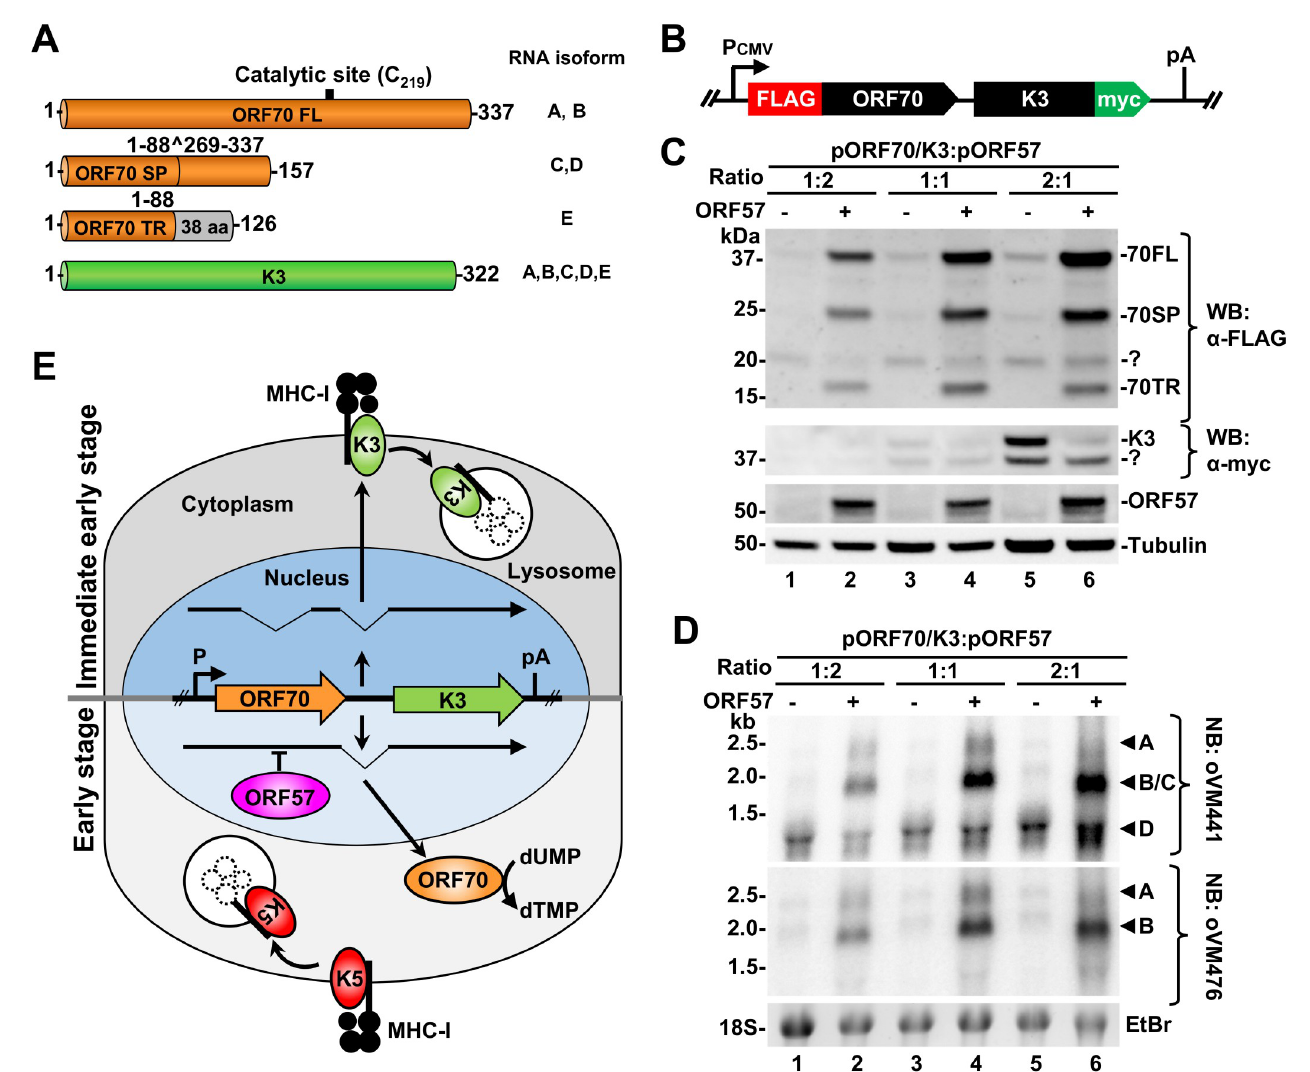
Fig 11. Ectopic ORF57 inhibits alternative splicing of bicistronic ORF70/K3 RNAs to regulate the expression of viral thymidylate synthase ORF70 and viral E3-ubiquitin ligase K3 in HEK293T cells. (A) A number of the amino acid residues of full length (FL), spliced (SP), truncated (TR) ORF70 and K3 proteins expressed from the corresponding RNA splicing isoforms are shown on the right (see details in Fig 10B ). (B) Diagram of an ORF70/K3 minigene with a FLAG-tag on the ORF70 N-terminus and a c-myc-tag on the K3 C-terminus. The minigene under control by a CMV IE promoter contains the viral genomic DNA fragment covering the K3 and ORF70 coding regions and their intergenic region to ensure RNA splicing of this bicistronic RNA transcript. (C and D) Western (C, WB) and Northern blot (D, NB) analyses of HEK293T cells transfected with various ratios of the ORF70/K3 minigene over the ORF57 expression (+) or empty (-) vectors. (C) Expression of ORF70 protein was detected by WB using an anti-FLAG and K3 protein using an anti-c-myc antibody. ?, unknown protein band. (D) The changes in ORF70/K3 RNA splicing from the minigene vector in HEK293T cells in the absence (-) or presence (+) of ectopic ORF57 expression were monitored by Northern blot analysis on total cell RNA with two separate oligoprobes shown in Fig 10B . The 18S rRNA level detected by ethidium bromide (EtBr) staining was used as a loading control. (E) A diagram depicting the role of ORF57 in the regulation of ORF70/K3 RNA alternative splicing to mediate a switch from K3 to ORF70 protein expression during KSHV lytic